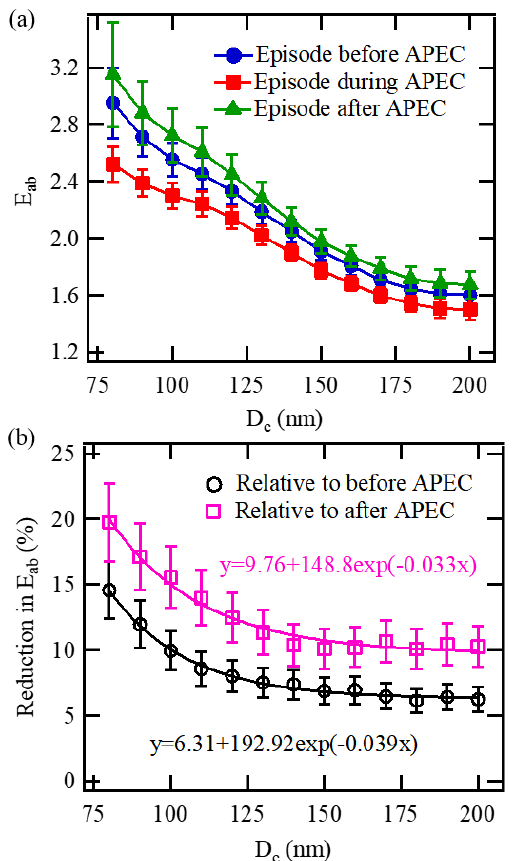
Figure 6. Comparison of the light-absorption capability of BC- containing particles during the day for the pollution episodes before, during and after APEC: (a) light-absorption enhancement ( E ab ) of BC-containing particles and (b) the reduction in E ab of BC- containing particles during APEC relative to those before and after APEC.